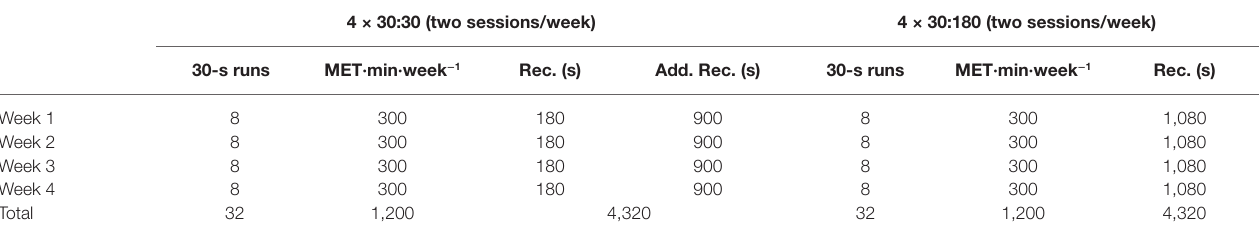
TABLE 1 | High-intensity interval training (HIIT) workload and recovery by